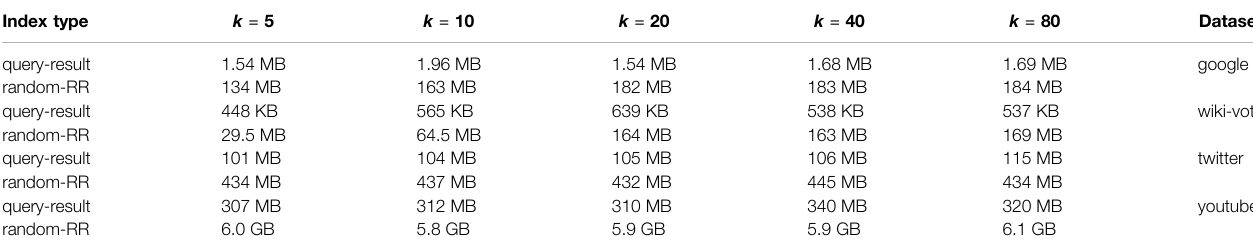
TABLE 2 | Space costs of indexes.